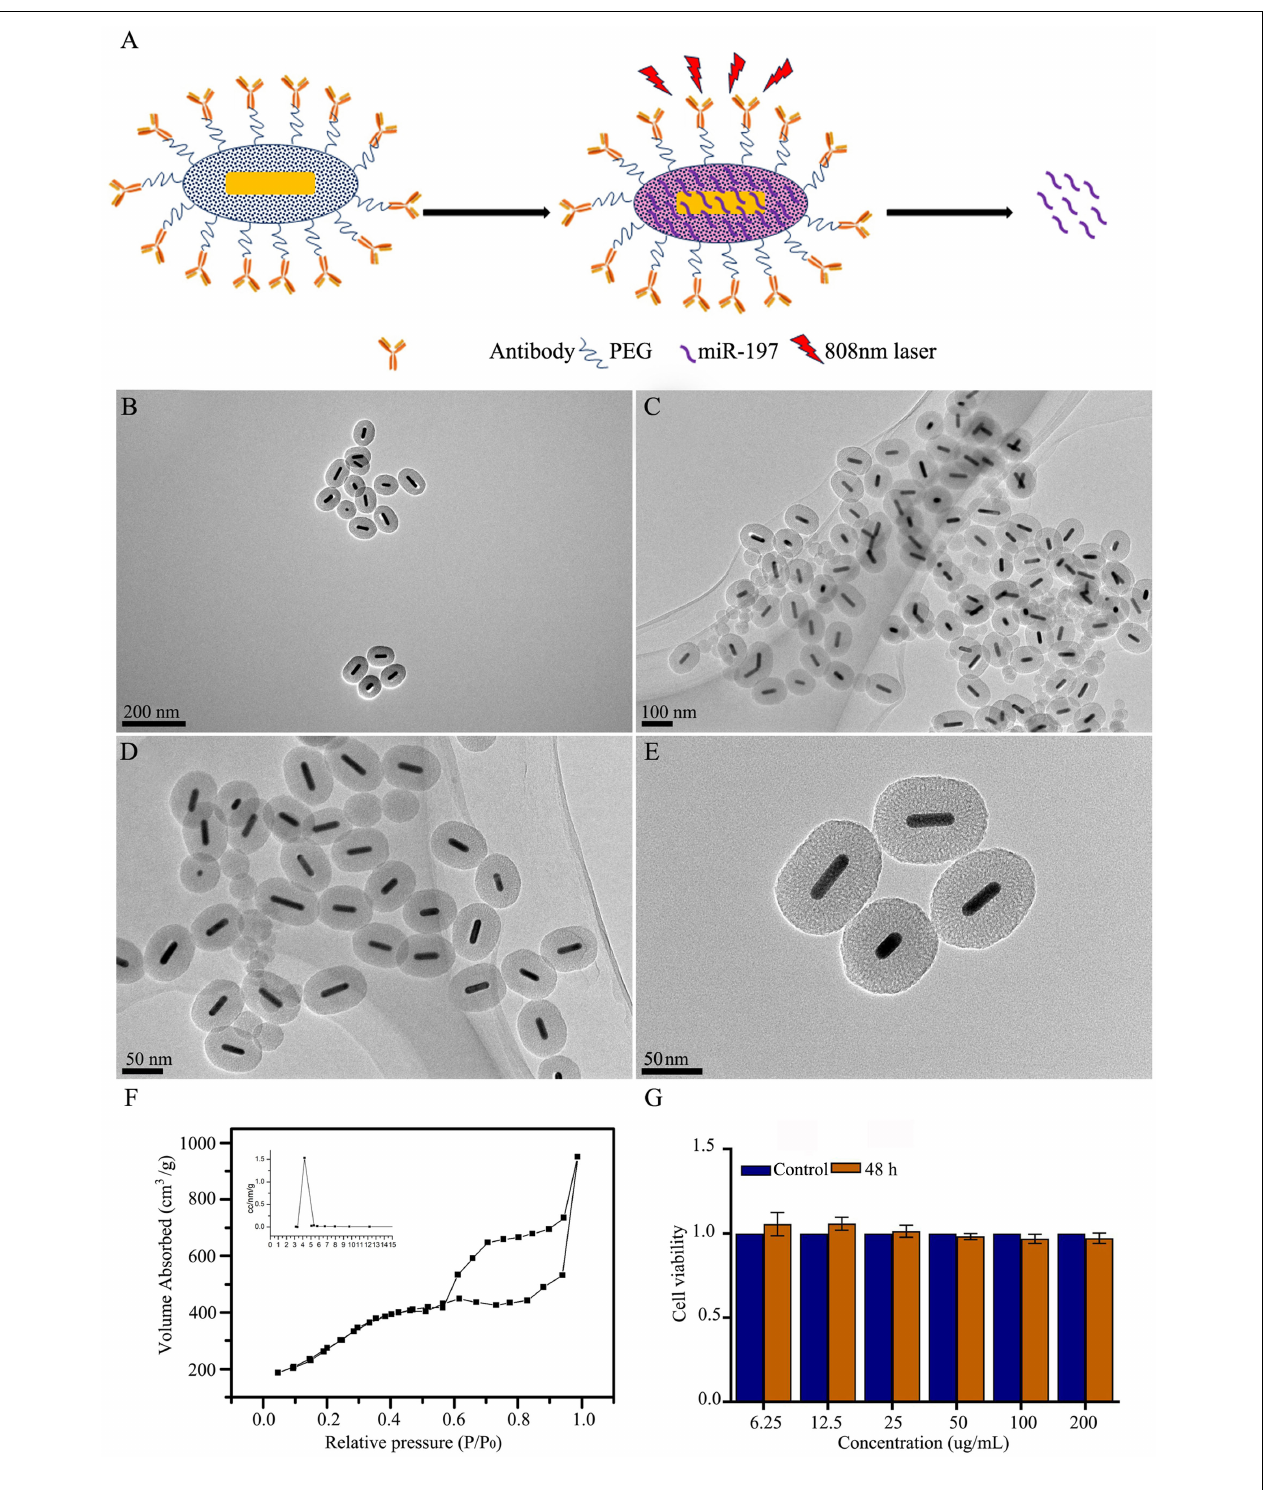
FIGURE 4 | Synthesis and characterization of mesoporous silica-coated gold nanorods. (A) GNR@MSNs and AbCD133@GNR@MSNs synthesis. (B–E) transmission electron microscopy (TEM) image of GNR@MSNs. (F) The mesoporous morphology and mesoporous distribution (inset) of the GNR@MSNs were determined using N2 adsorption–desorption isotherms. (G) Cell Counting Kit-8 (CCK-8) assay was conducted to test the biocompatibility of AbCD133@GNR@MSNs on prostate cancer stem cells (PCSCs).